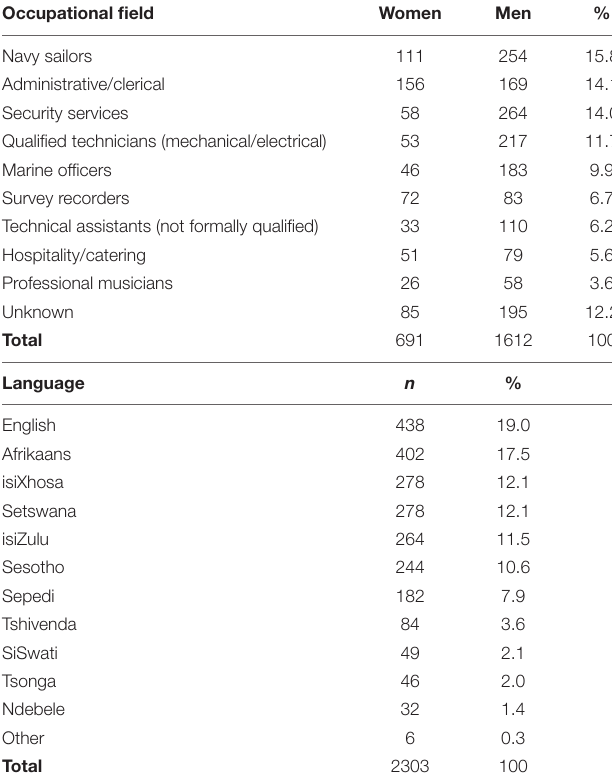
TABLE 1 | Sample composition across gender and occupational